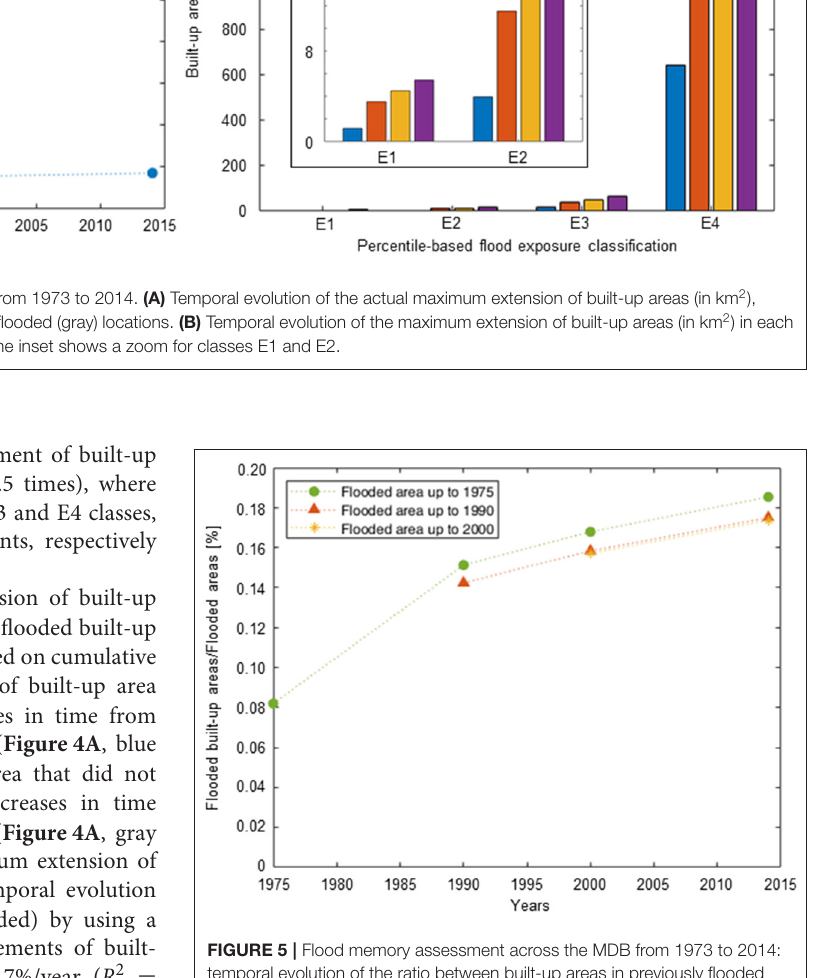
flooded and not-flooded locations ( Supplementary Figure 2